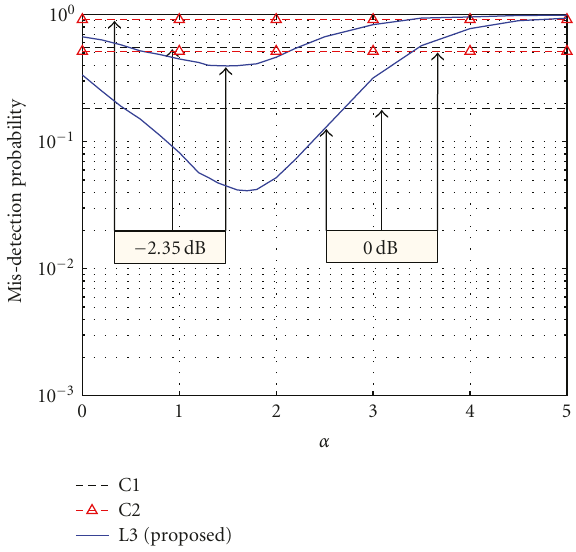
Figure 4: Misdetection probability of the L3 detector for di ff erent correction weights at CFAR of 10 − 3 ( f m T s = 0 . 2).